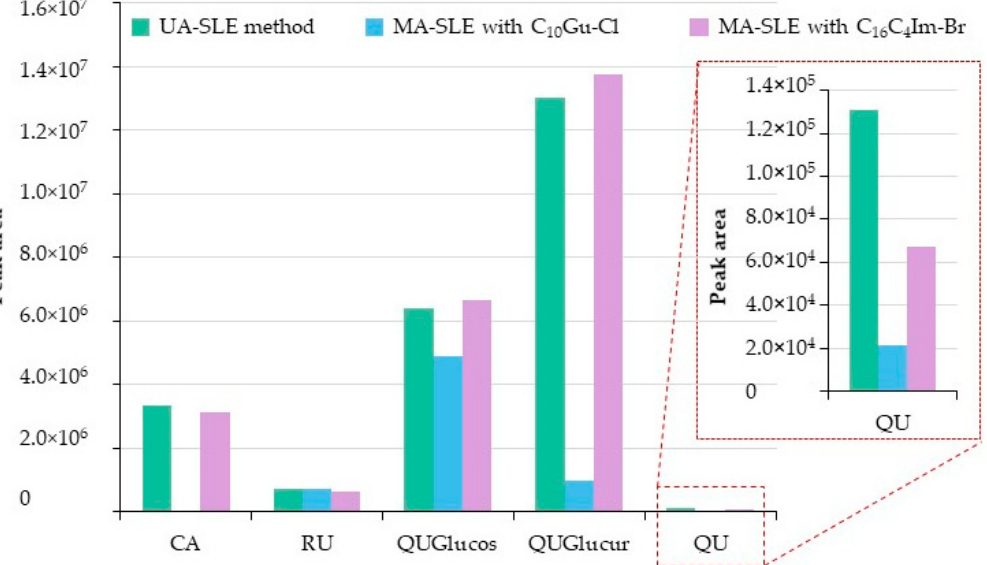
Figure 1. Preliminary screening of the extraction performance (evaluated as peak area) of the proposed MA-SLE method, using C 10 Gu- Cl and C 16 C 4 Im- Br IL-based surfactants in comparison with the UA-SLE method used as reference method. The preliminary experimental conditions for the MA-SLE method were 100 mg of leaves, 2.25 mL of IL-based surfactant aqueous solution at 2.5 mM for C16C4Im- Br and 300 mM for C 10 Gu- Cl , MW treatment at 70 °C, and 50 W for 30 min. Legend: CA, caftaric acid; QU, quercetin; QUGlucos, quercetin-3- O -glucoside; QUGlucur, querceting-3- O -glucuronide; RU, rutin.